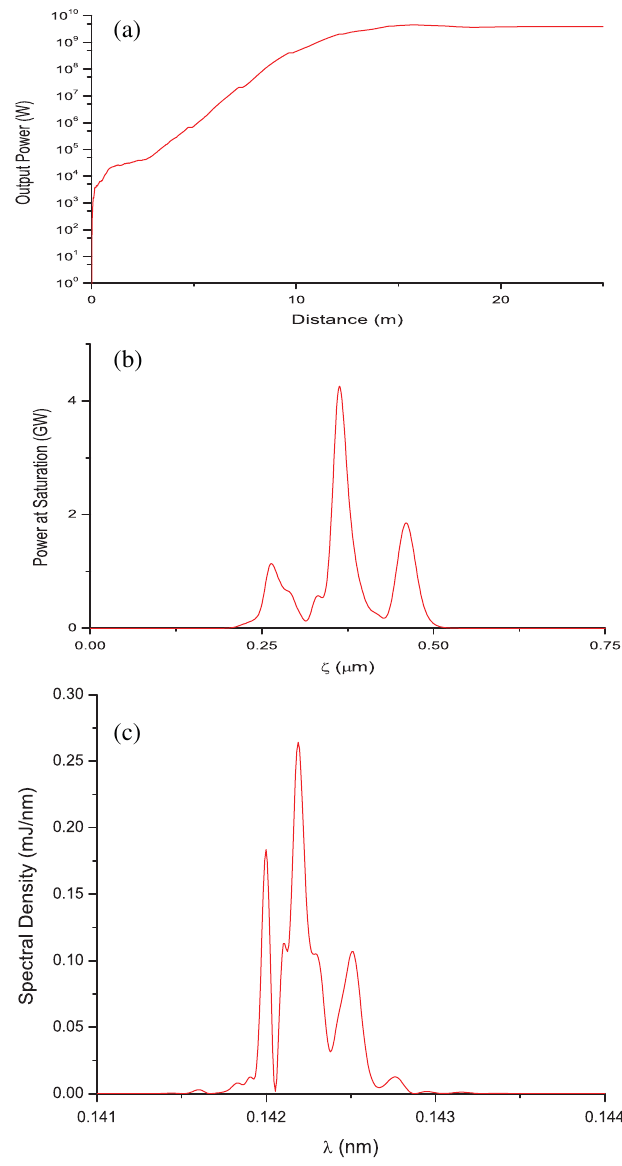
FIG. 7. (Color) (a) GENESIS simulation results for the 4.5 GeV LCLS beam. The saturation length of the fundamental mode is 15 m with a gain length of 70 cm. (b) At saturation the beam shows three spikes in the longitudinal profile, consistent with a 11 nm cooperation length [45]. (c) The fundamental interaction wavelength is just over 1.42 A˚